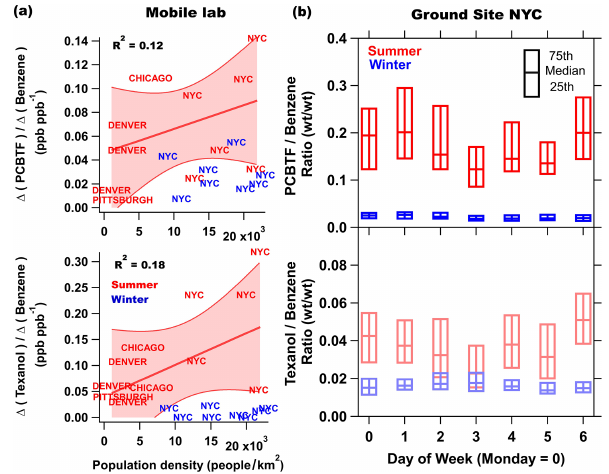
Figure 3. (a) The enhancement of PCBTF and Texanol relative to the enhancement of benzene versus the population density in sum- mer (red) and winter (blue) in various cities. Enhancements were calculated by subtracting the background median taken from mea- surements upwind of cities with the lowest mixing ratios from me- dian concentrations from regions where population density was the highest. Denver and Chicago are represented by multiple drives. NYC is an average of all drives throughout the city but separated by regions with high (19000–23000 people per square kilome- ter), medium (14000–19000 people per square kilometer), and low (9000–14000 people per square kilometer) population densities. (b) The summer and winter weekly profile of the PCBTF and Texanol versus benzene